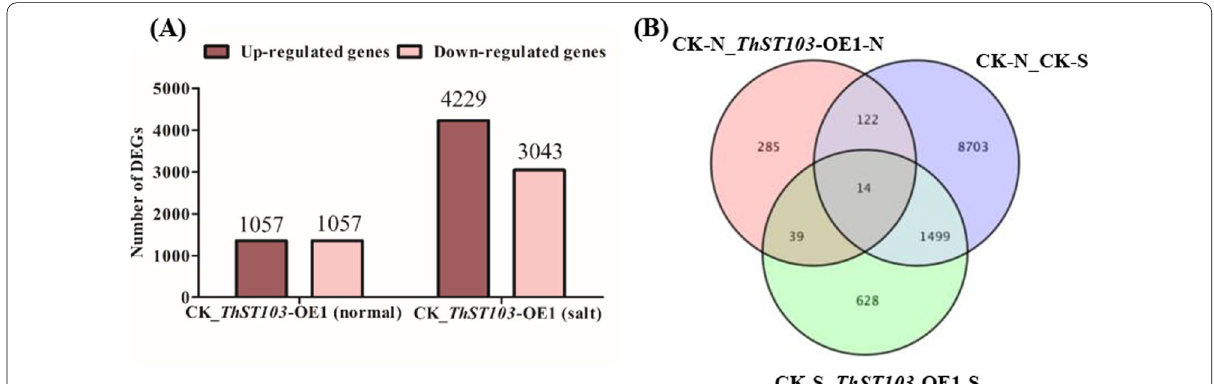
Fig. 5 Expression profiling of cotton seedlings under normal and saline stress. A Number of differentially expressed genes (DEGs) in CK and ThST103 -OE under normal and salt stress. B Venn diagram analysis of the common and specific genes that are unique and shared between the different pairwise